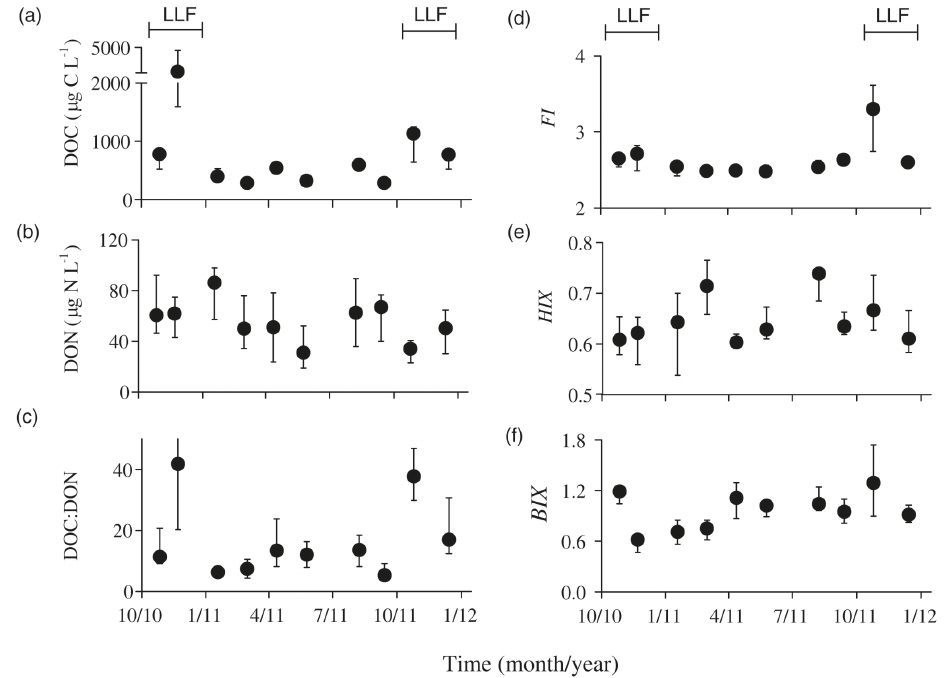
Figure 3. Temporal pattern of (a) dissolved organic carbon (DOC), (b) dissolved organic nitrogen (DON), (c) DOC:DON molar ratio, (d) fluorescence index (FI), (e) humification index (HIX), and (f) biological index (BIX) in stream water. FI, HIX, and BIX were calculated from fluorescence spectroscopy. Symbols are medians and whiskers are 25th and 75th percentiles for samples collected along the main stream. The leaf litter fall (LLF) period is indicated.